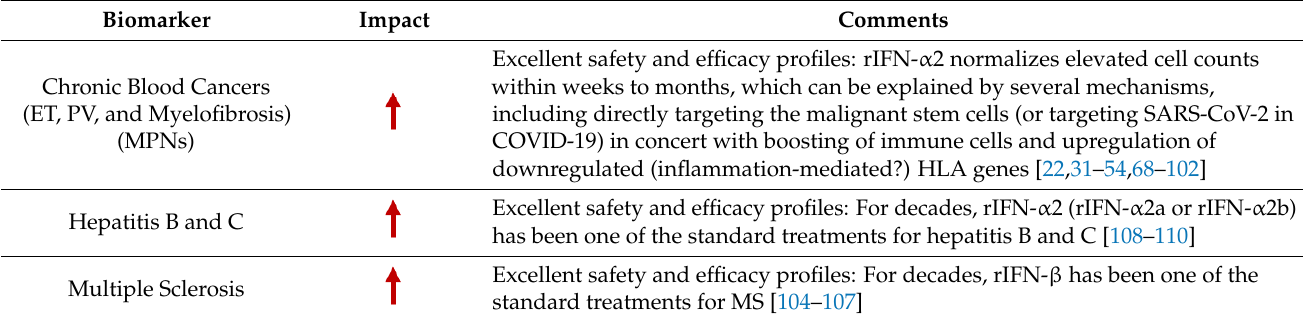
Table 2. Cont. Table 2. Rationales for treatment with rIFN- α2 and rIFN - β in patients with MPNs and COVID-19.